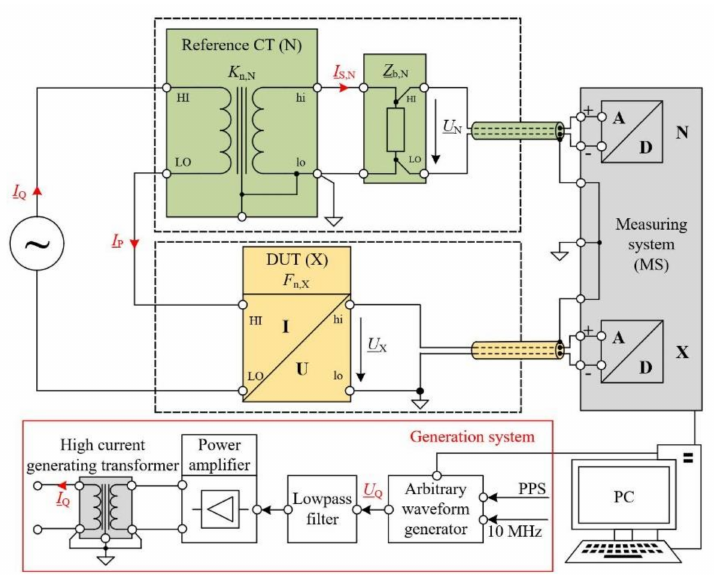
Figure 2. Block diagram of the generation and measurement setup for current sensor under